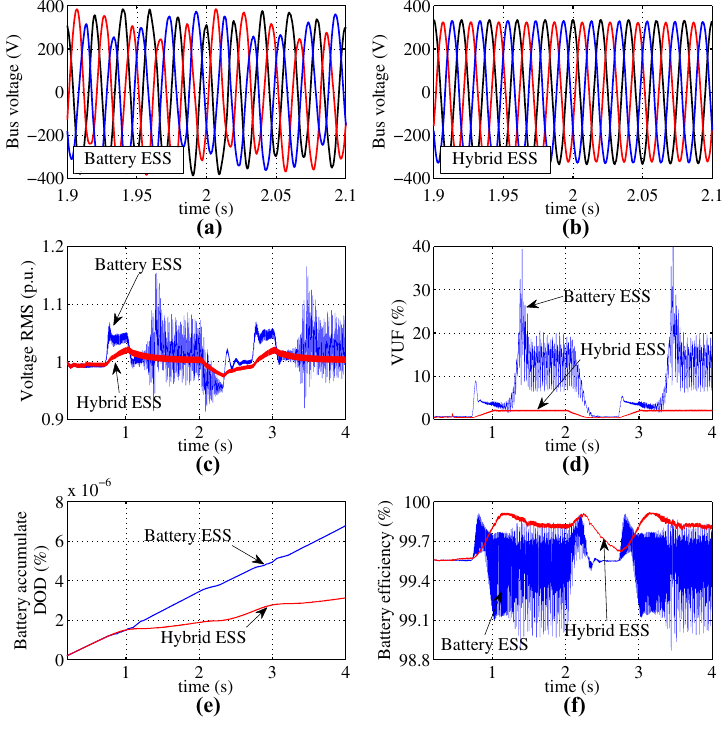
Figure 10. Simulation comparison between battery ESS and hybrid ESS in a standalone microgrid under single-phase power generation. (a) Bus voltage with battery ESS; (b) bus voltage with hybrid ESS; (c) comparison of RMS bus voltage; (d) bus voltage unbalance factor; (e) battery accumulate DOD; and (f) battery